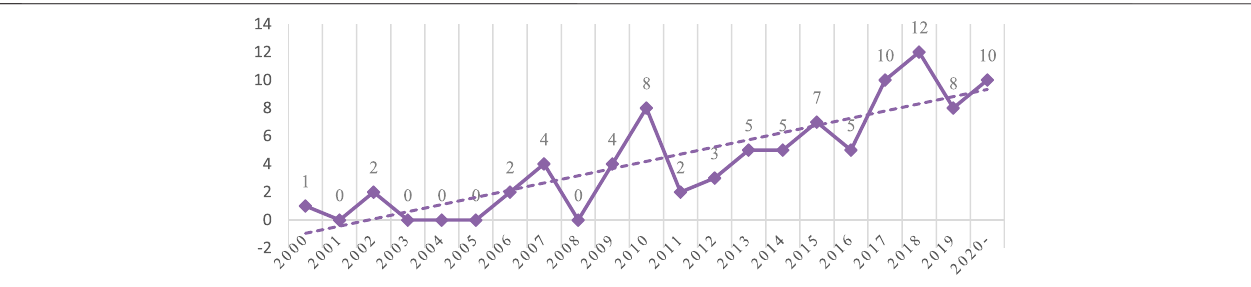
FIGURE 3 | Frequency distribution of publications by